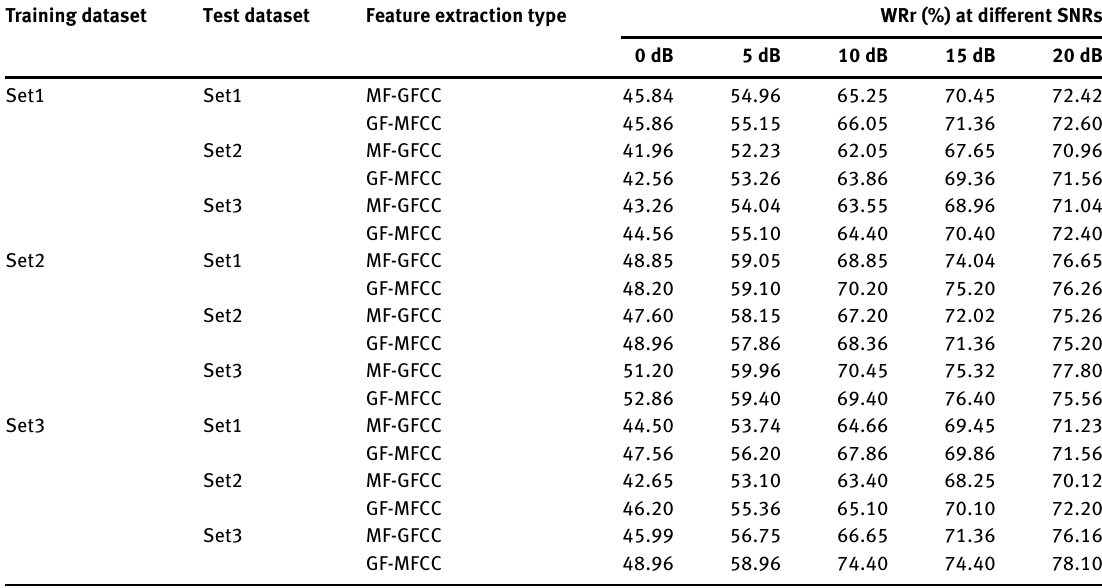
Table 2: Performance Analysis in Different SNR (dB) Environment. Training dataset